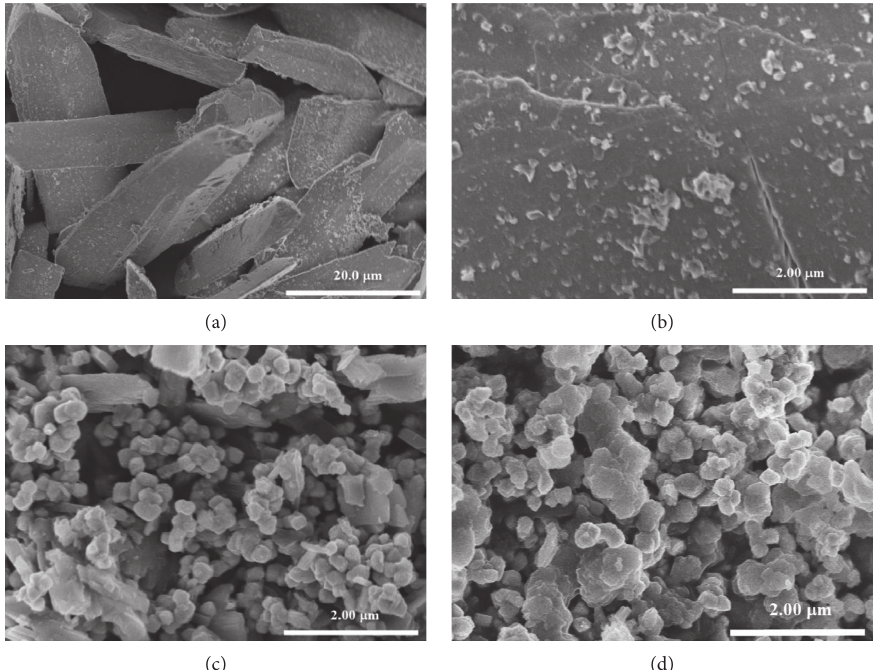
Figure 8: SEM images of iron (III) benzene dicarboxylate samples synthesized at 150 ° C with different reaction times and different molar ratios of Fe (III)/BDC: (a), (b) 1:2, 24h; (c) 1:1, 24h; and (d) 1:1,